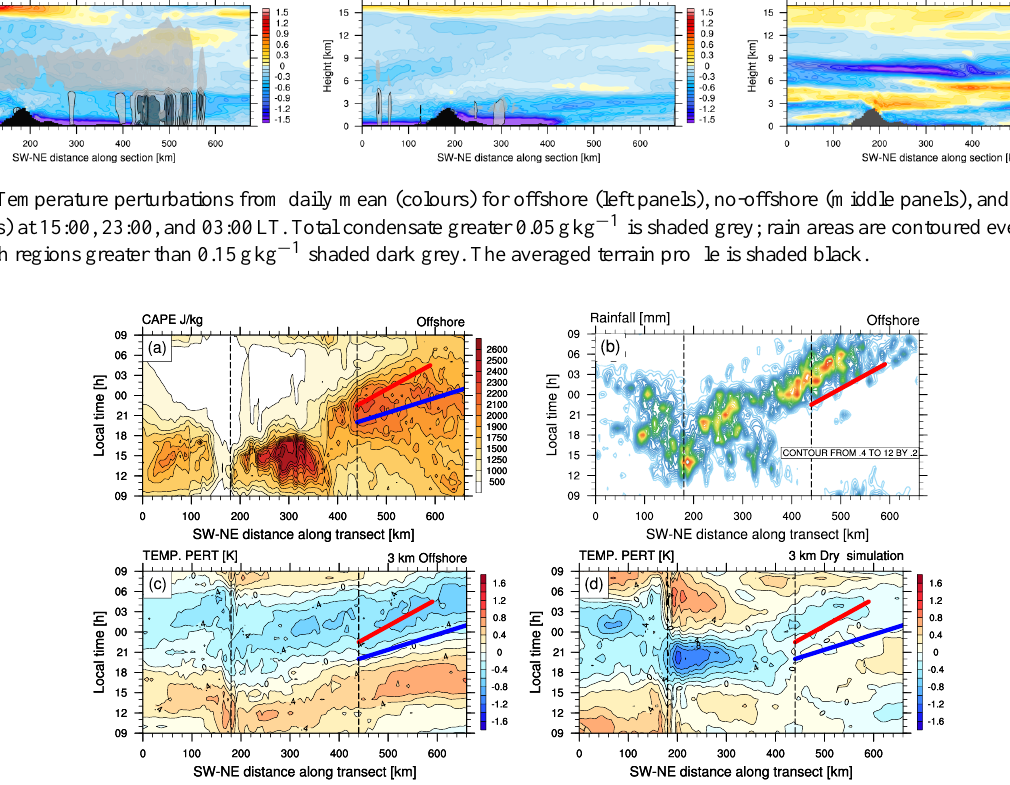
Figure 12. Mean diurnal cycles of (a) CAPE, (b) rainfall, and (c) temperature perturbations from daily mean for offshore days. (d) As in panel (c) but for the dry simulation. Dashed vertical lines indicate the position of the ridge and northern coastline respectively. The phase speed of the red line (denoting rainfall onset) is ∼ 8ms − 1 while the phase speed of the blue line (denoting cooling onset) is ∼ 15ms − 1